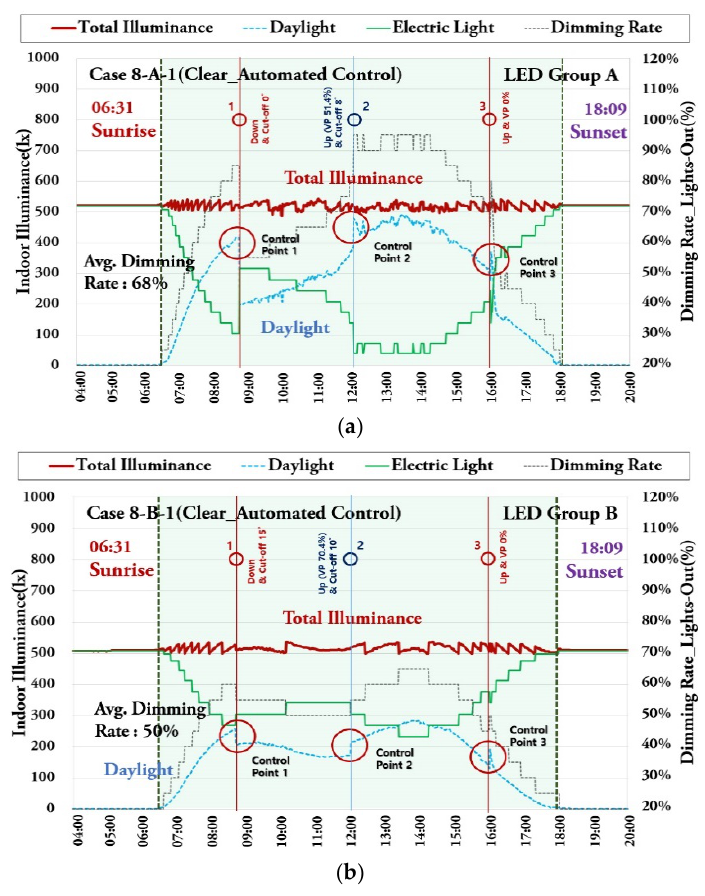
Figure 20. Illuminance and dimming rates under dimming controls integrated with automatic blind control. (three steps, clear sky_10.03). ( a ) Case 8-A-1 and ( b ) Case 8-B-1 in Table 7.